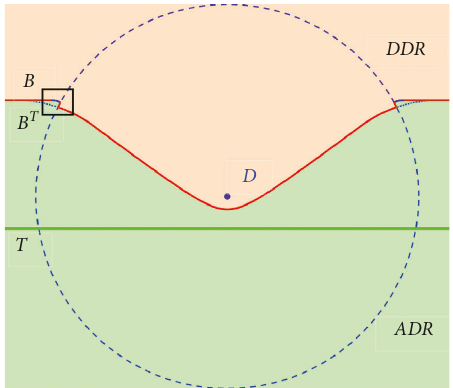
Figure 13: The barrier when min θ